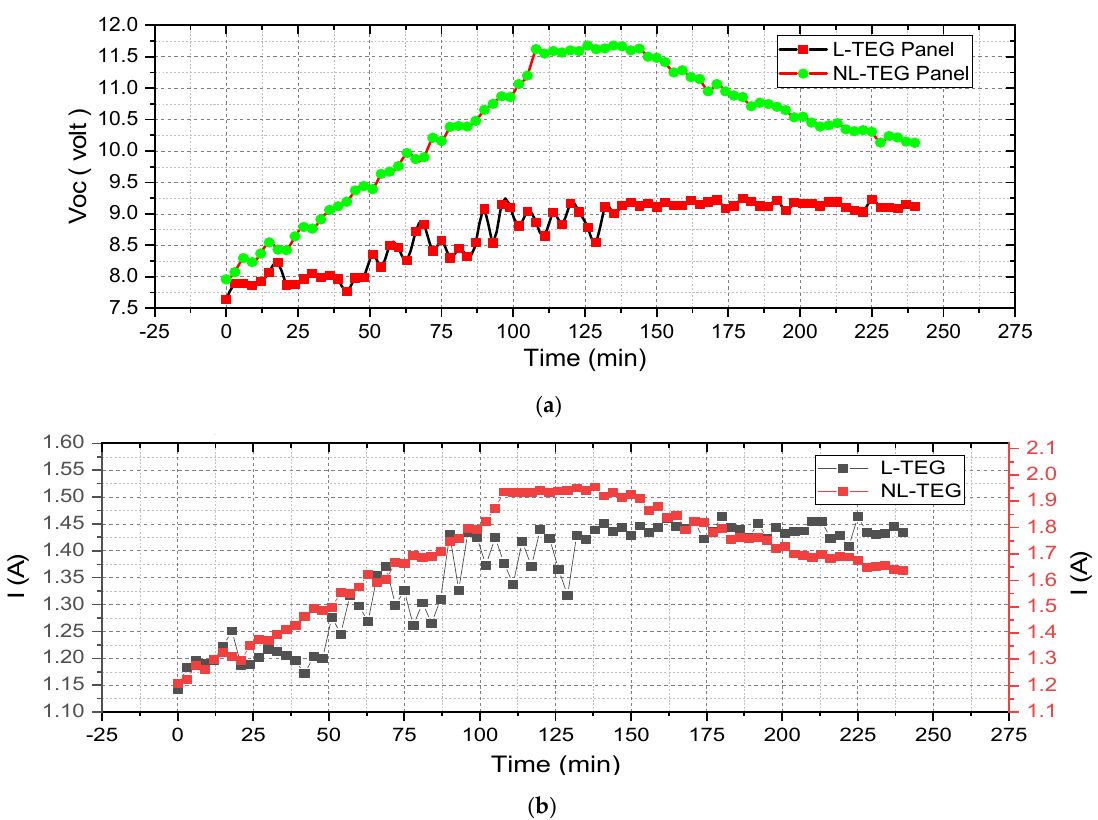
Figure 10. ( a ) Voltage for L-TEG and NL-TEG systems, ( b ) Current for L-TEG and NL-TEG systems.